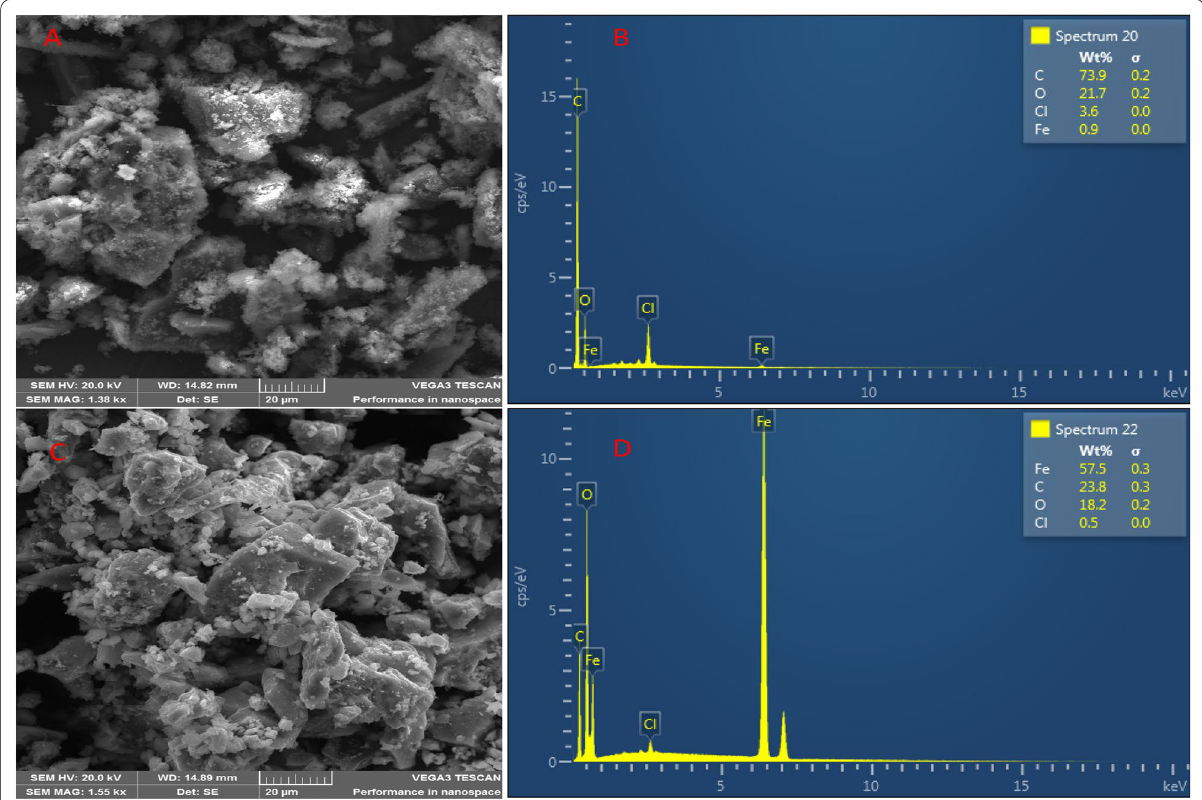
Fig. 4 SEM images indicating the external morphologies of PABA/AC ( a ), Fe 3 O 4 @PABA/AC ( c ) and EDS spectrum of PABA/AC ( b ) and Fe 3 O 4 @PABA/ AC